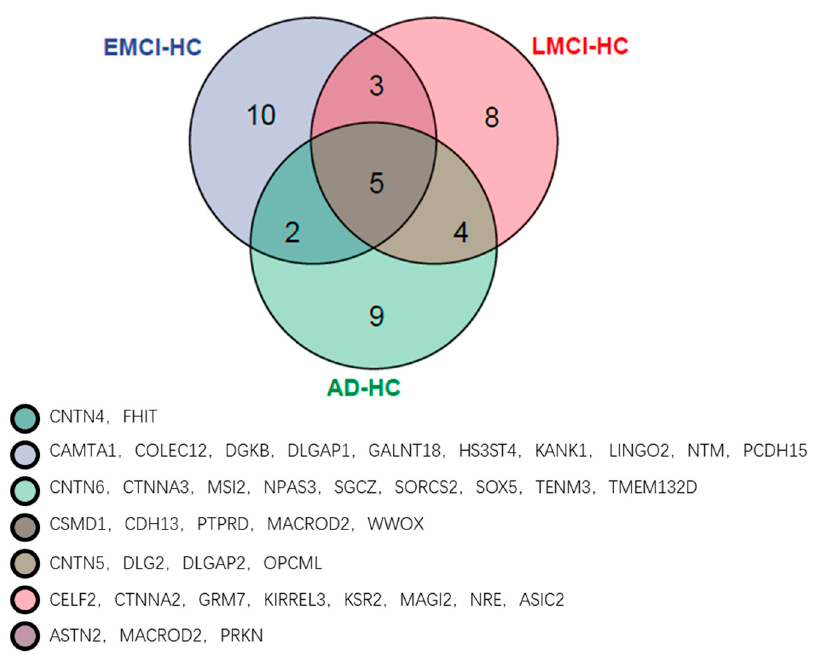
Figure 14. The top 20 genes of the EMCI − HC group, LMCI − HC group and AD − HC group.